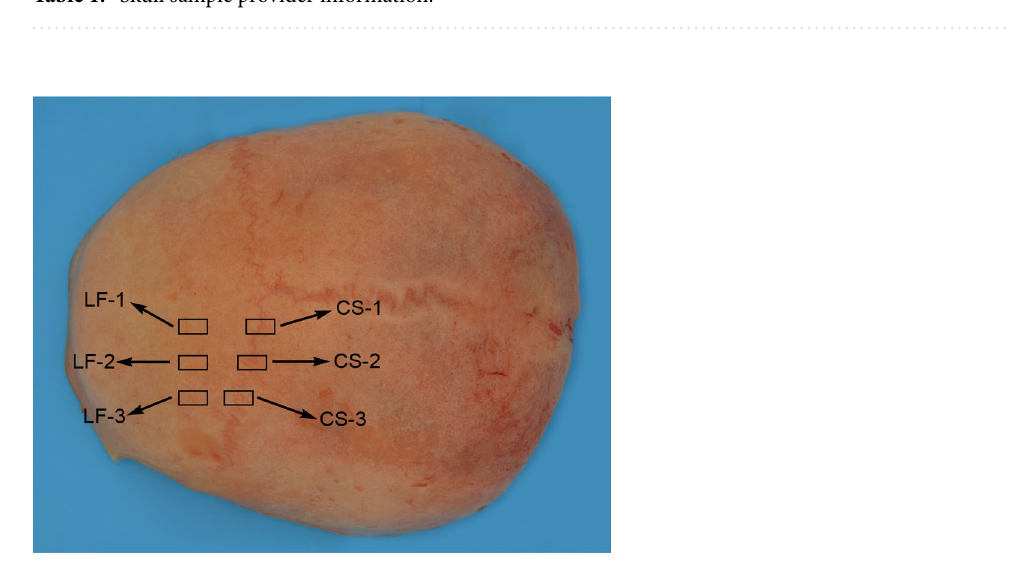
Table 1. Skull sample provider information.